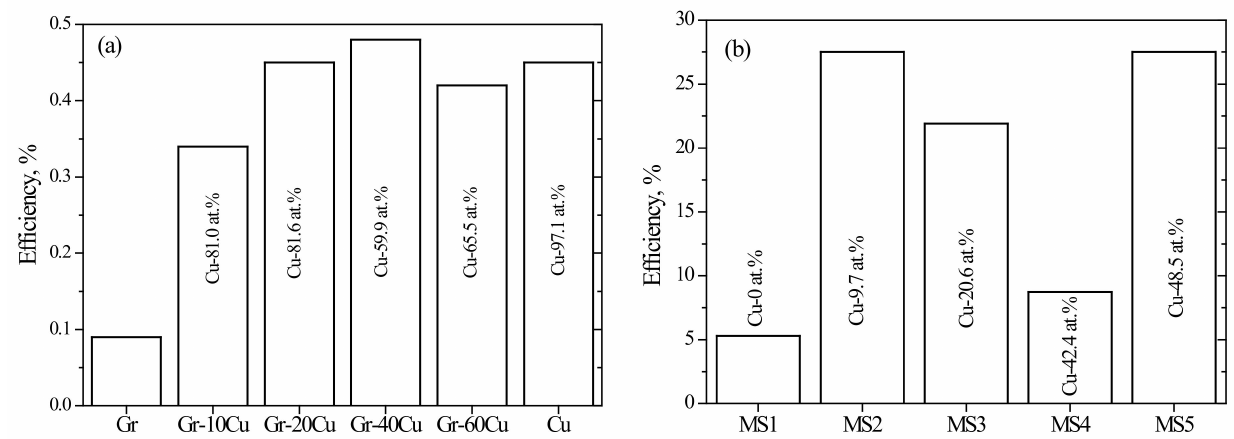
Figure 6. Variation in the Schottky photodiode efficiency of the films when deposition was performed using ( a ) plasma spraying and ( b ) magnetron